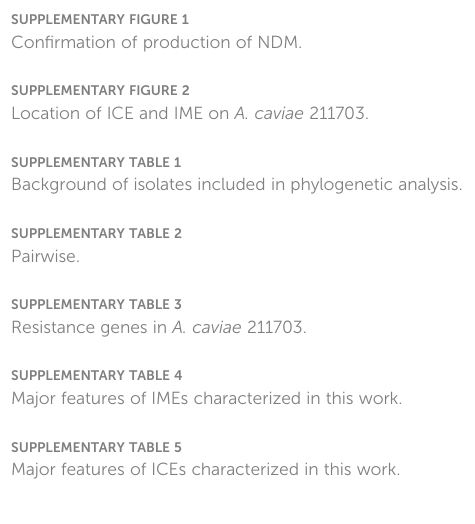
SUPPLEMENTARY FIGURE 1 Con fi rmation of production of NDM. SUPPLEMENTARY FIGURE 2 Location of ICE and IME on A. caviae 211703. SUPPLEMENTARY TABLE 1 Background of isolates included in phylogenetic